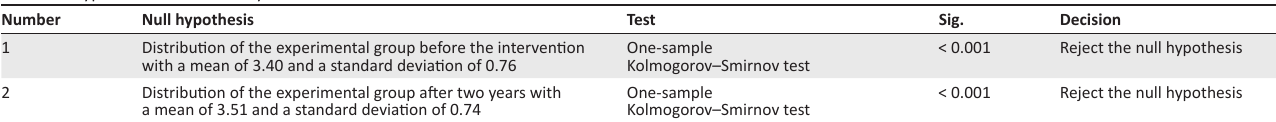
TABLE 3: Hypothesis test